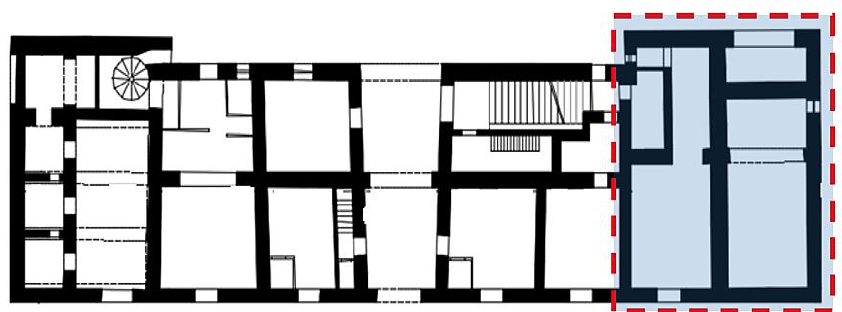
Figure 7. Heading structural unit in isolated condition.